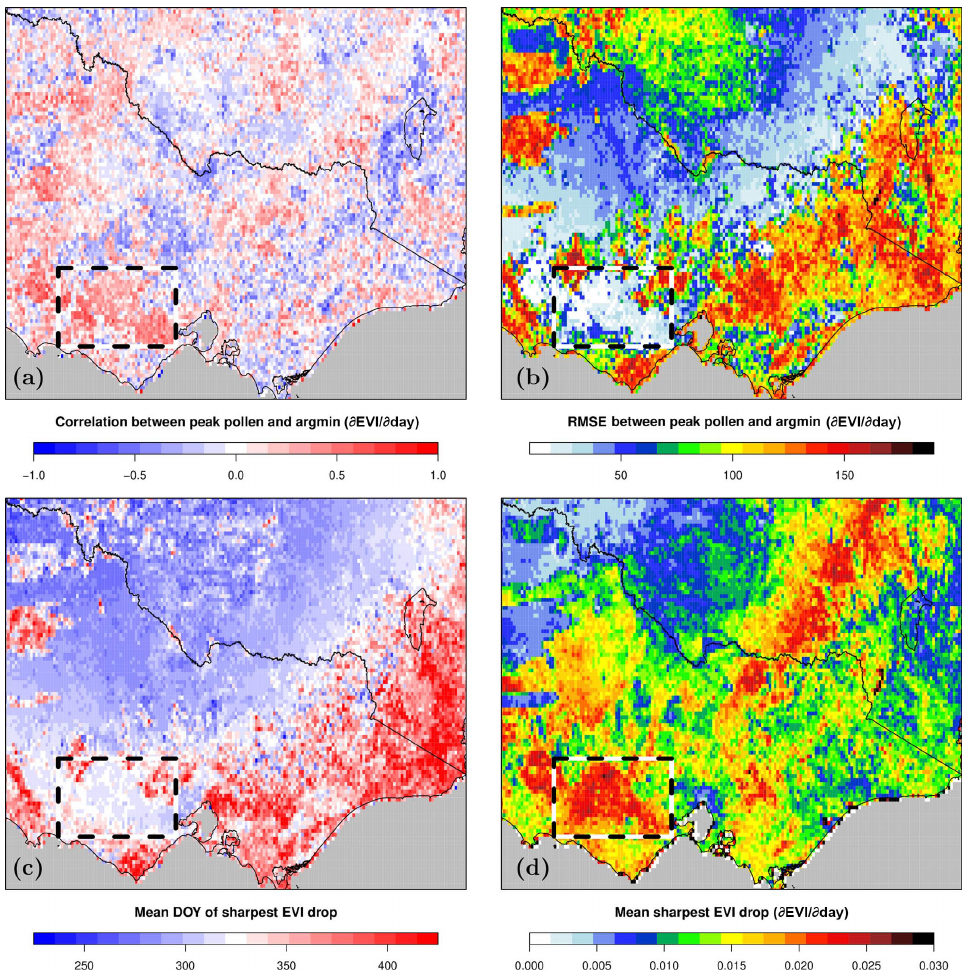
Figure 3. Relationship between the timing of the peak in grass pollen in Melbourne and the timing of the sharpest drop in EVI at each MODIS pixel: the correlation (a) and the root mean squared error in the timing (b) . Also shown are the average timing (c) and rate (d) of the fastest fall in EVI at each point in the domain. The dashed rectangle in south-west Victoria (spanning 37.3–38.3 ◦ S and 142.0–143.3 ◦ E) displays the region over which the EVI time-series were averaged for Fig. 2. “argmin” refers to the minimum